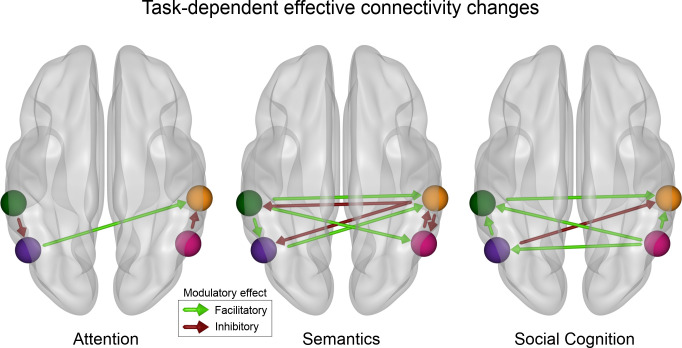
Tasks cause different effective connectivity modulations among IPL subregions.The modulation assessed by dynamic causal modeling (DCM) of directed connectivity among the four IPL subregions differs between attentional reorienting, lexical decisions, and perspective taking. Only significant modulatory parameters (α ≤ 0.01) are shown (based on the non-parametric permutation analysis). Attentional reorienting induces comparatively simple connectivity modulations, while both other tasks are characterized by richer changes in the modulatory influences between subregions. Lexical decisions increase facilitatory influences from the left to the right hemisphere and inhibition from the right to the left. Perspective taking causes bilateral increases in the facilitatory influence from posterior to anterior subregions. Green: DCM node in the left anterior subregion (L-ant). Violet: DCM node in the left posterior subregion (L-post). Orange: DCM node in the right anterior subregion (R-ant). Pink: DCM node in the right posterior (R-post) subregion.